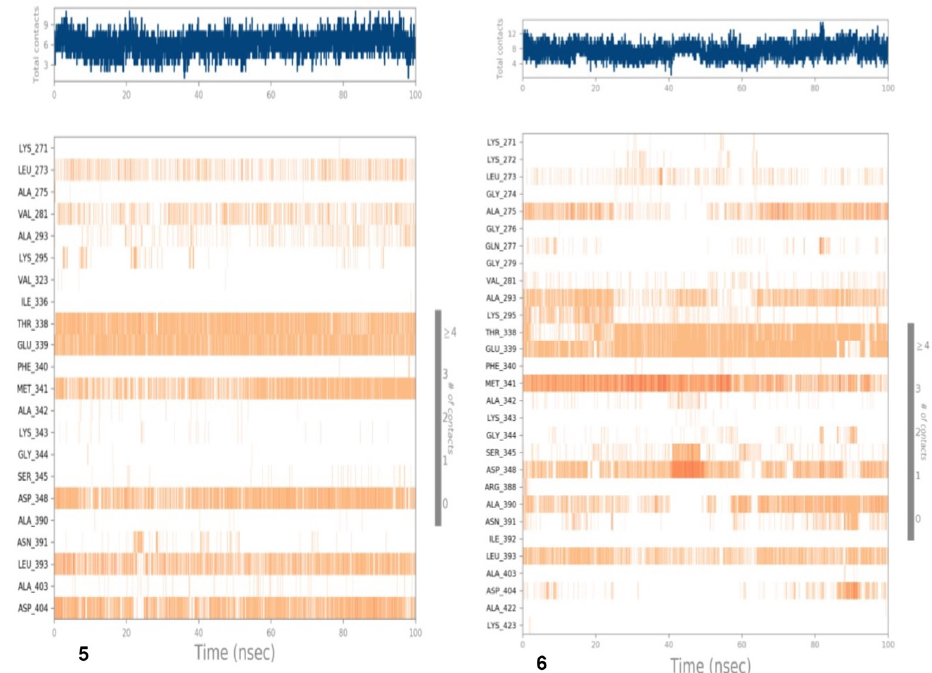
Figure 10. Timeline representation of the interaction and contacts. Top panel shows specific contact of ligand and protein during 100 ns simulation of compounds 5 and 6 with 2HCK.